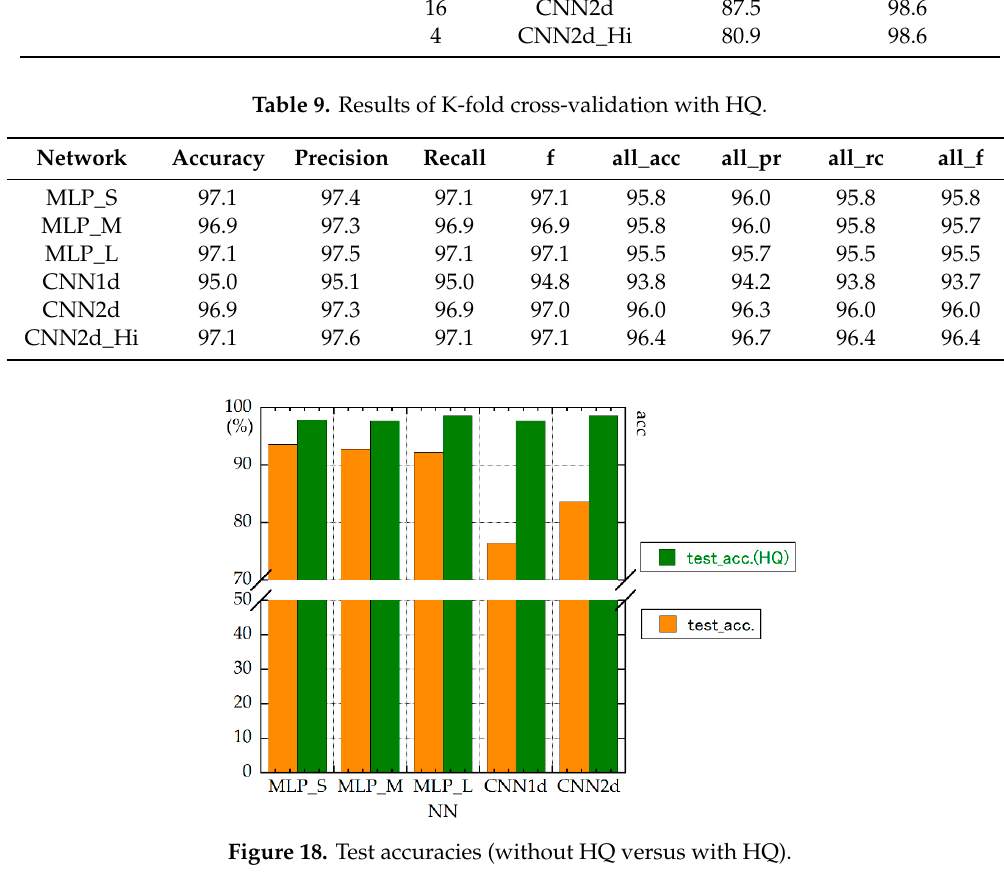
Table 8. Accuracy of each NN (best test_acc) with HQ.